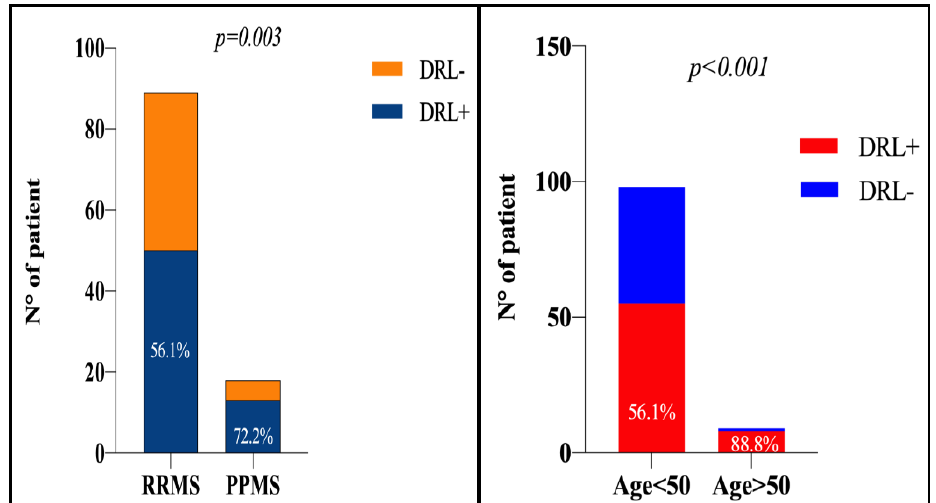
Figure 3. Histogram of the dark rim lesion’s distribution according to MS phenotype ( left ) and age of the patient ( right ). DRL = dark rim lesions; MS = multiple sclerosis; RRMS = relapsing-remitting MS; SPMS = secondary progressive MS.